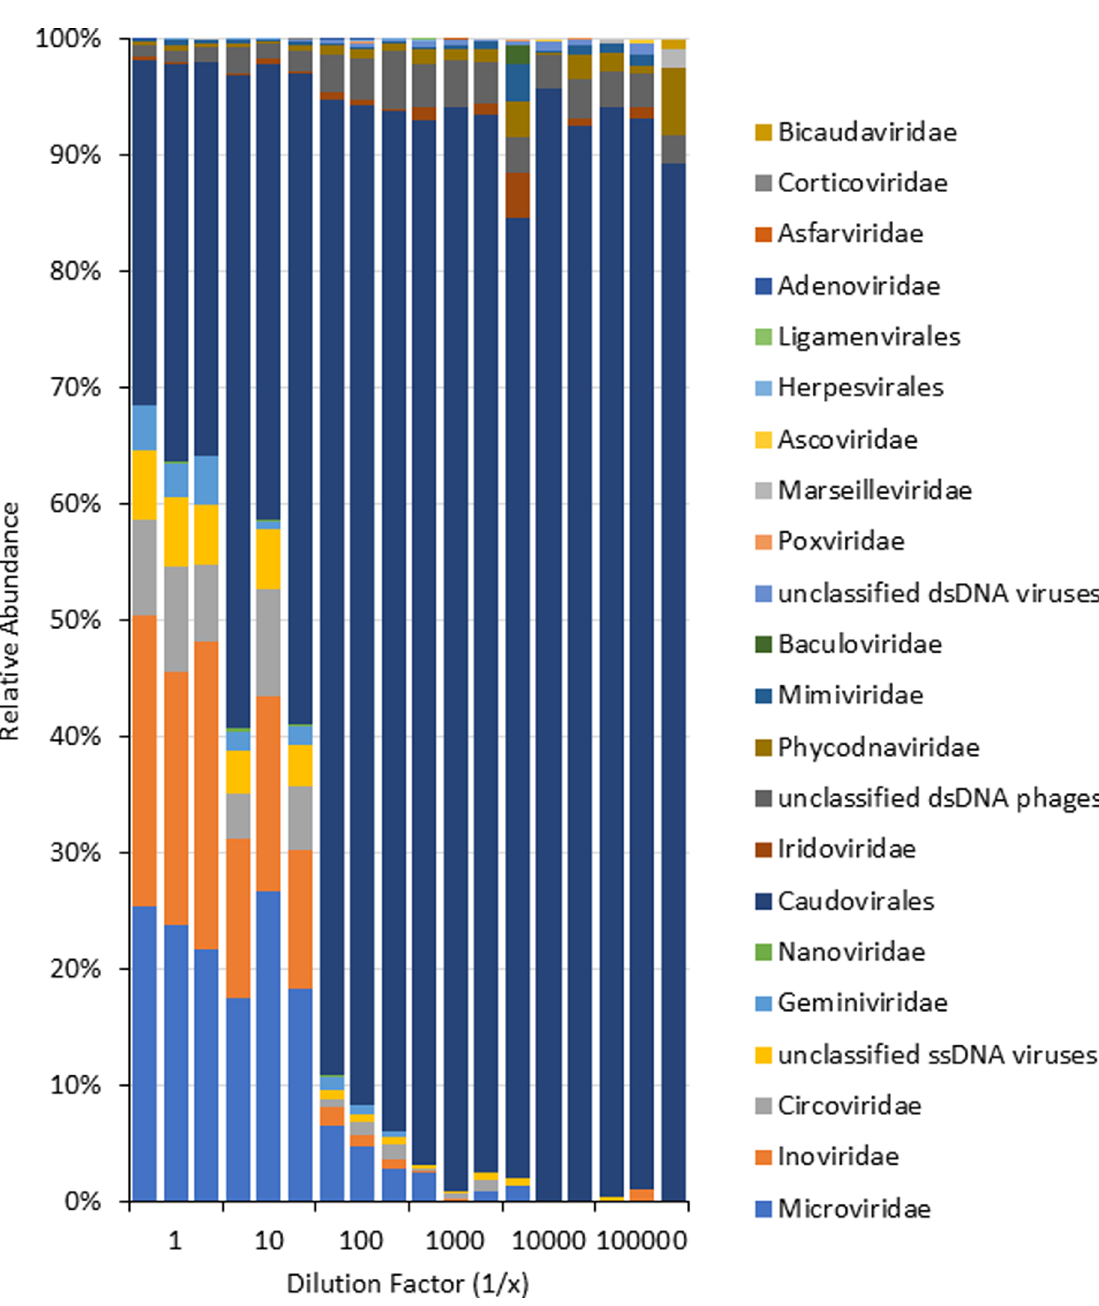
Fig 6. Relative abundance of virus groups and families in a dilution series of a single wastewater sample.